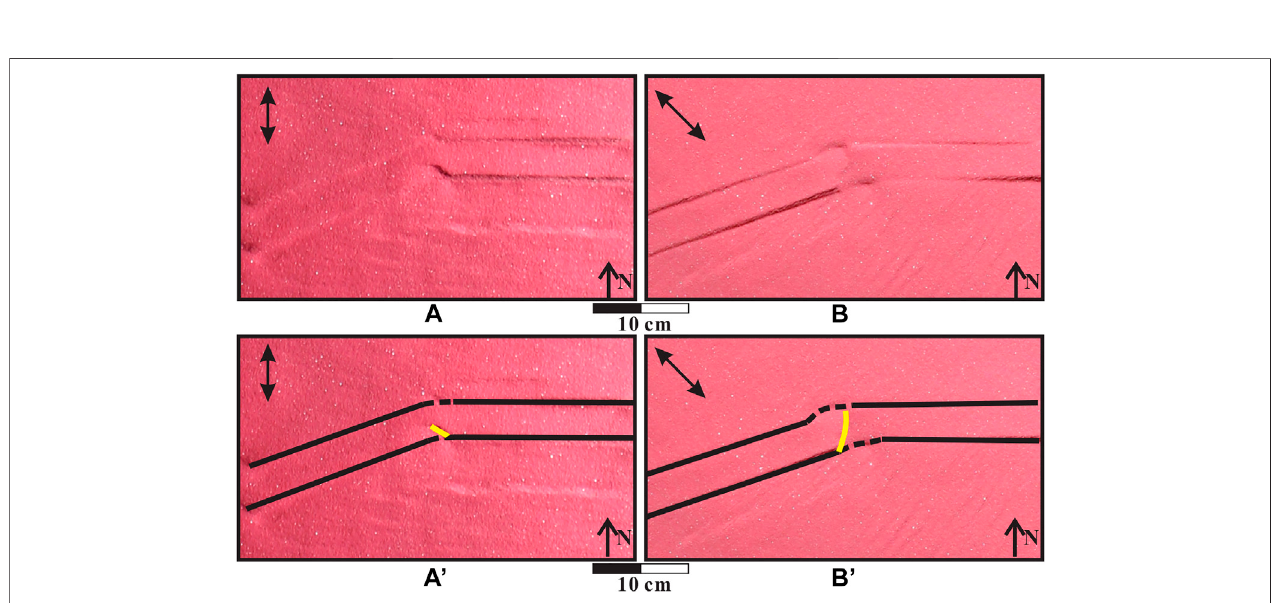
FIGURE14| ModelingresultsofSeriesIIIexperiments. (A) AsmallNW-SE-strikingfaultisformedatthetailoftheE-W-strikingpre-existingfaultsunderaN-Sstress direction. (B) An NE-SW-striking fault is formed at the transfer zone of the E-W-striking pre-existing faults under a N-S stress direction. The faults are shown in (A ’ ) and (B ’ ) , where the black lines denote pre-existing faults, the black dotted lines denote the arc extension of pre-existing faults, and the yellow lines denote the new faults.